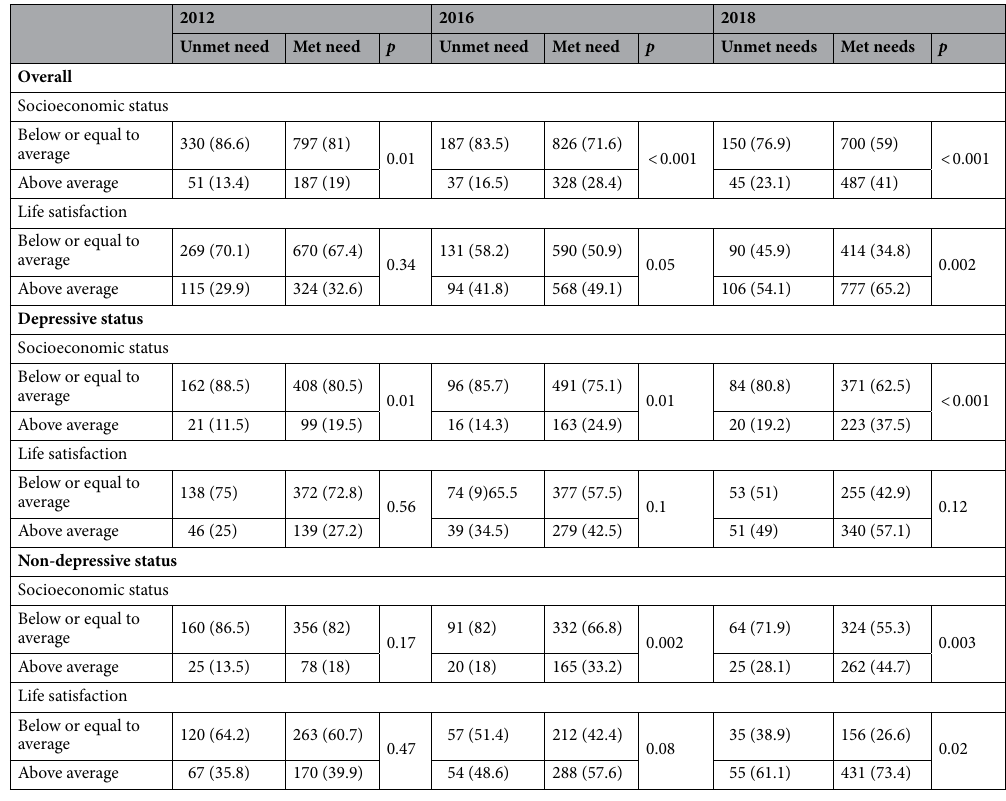
Table 2. Relationship between health care needs, SES and life satisfaction and stratified by depressive status in different follow-ups, n